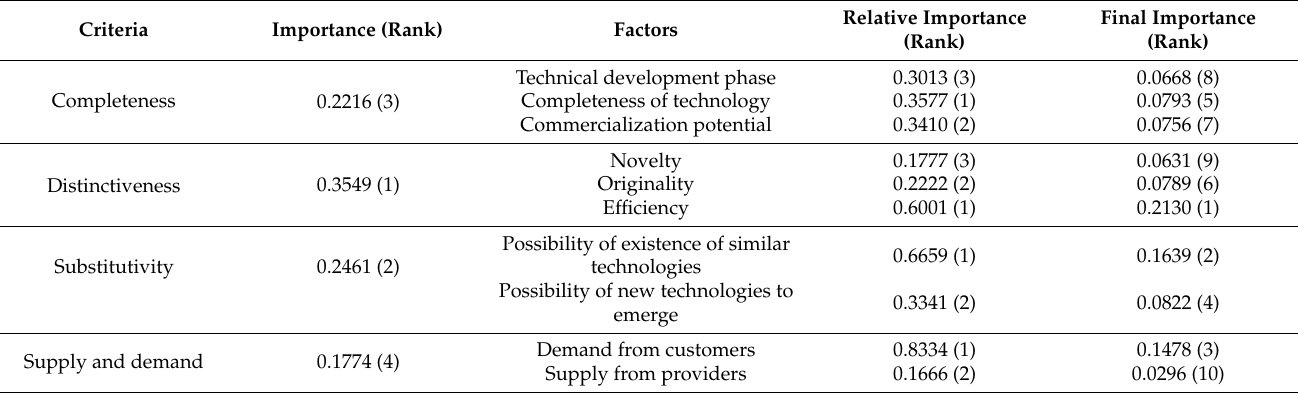
Table 6. Weight calculation of the assessment